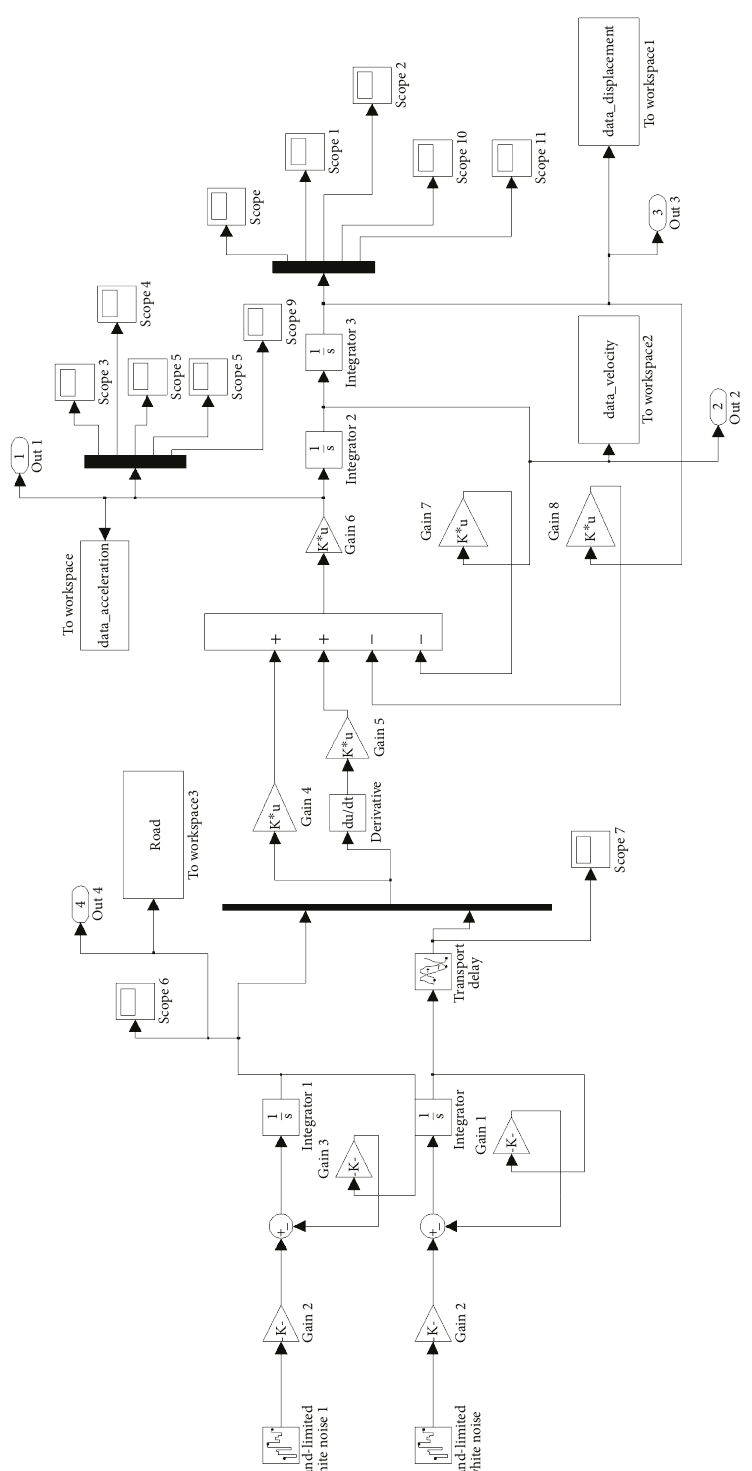
Figure 4: Vibration simulation